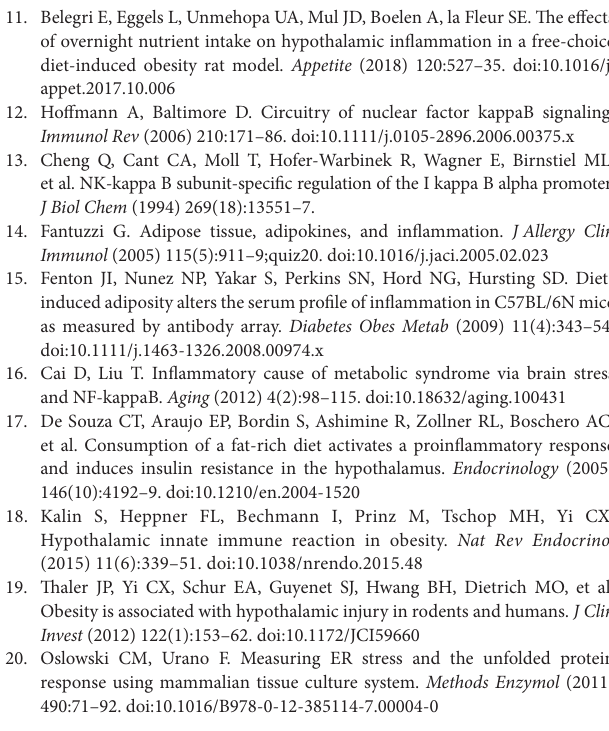
FigUre s1 | Protein expression of nuclear factor of kappa light polypeptide gene enhancer in B cells inhibitor alpha (NF κ BIA) in hypothalamic homogenates of rats after one week on free-choice high-fat high-sugar (fcHFHS) or chow diet and 2 h lipopolysaccharide (LPS) or saline (IP) administration. Blots were incubated with I κ B α rabbit monoclonal antibody against NF κ BIA and goat anti rabbit-horseradish peroxidase against I κ B α . Specific bands were detected by chemiluminescence, and the intensity of bands was quantified by optical densitometry. FigUre s2 | Protein expression of beta actin in hypothalamic homogenates of rats after 1 week on free-choice high-fat high-sugar (fcHFHS) or chow diet and 2 h lipopolysaccharide (LPS) or saline (IP) administration. Blots were incubated with Actin I-19 goat polyclonal IgG against beta actin and rabbit anti goat-horseradish peroxidase against Actin I-19. Specific bands were detected by chemiluminescence, and the intensity of bands was quantified by optical